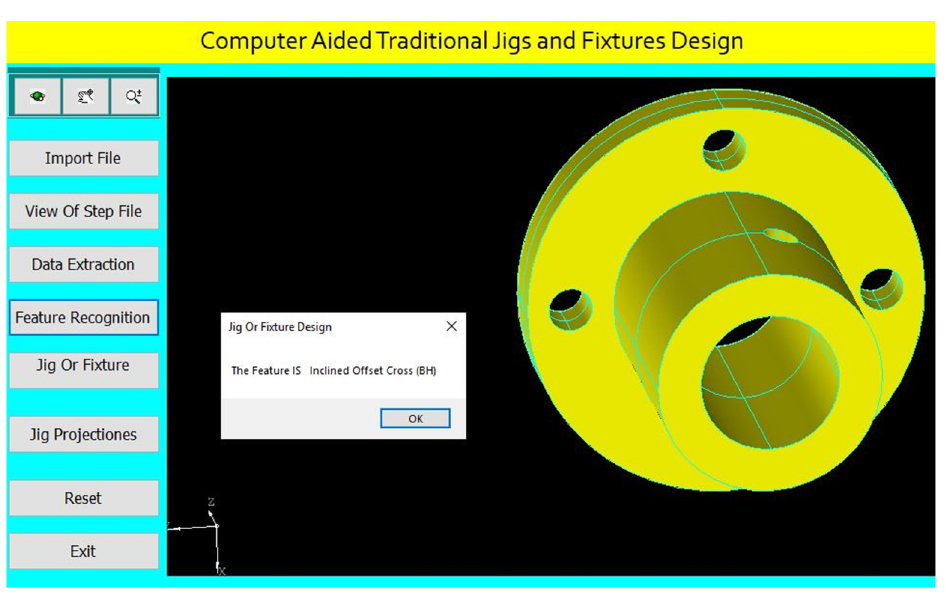
Figure 36. Automatic feature recognition of an inclined offset cross blind hole. The program checks the inclined offset cross blind hole of (4 mm) diameter for identifying the suitable guide bush.